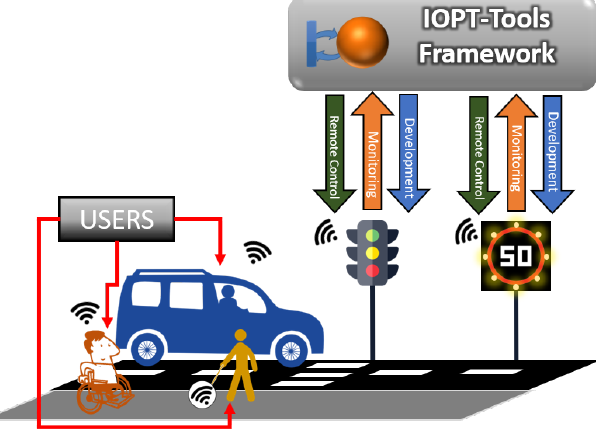
Figure 1. Mobility Assistive System (NOVA-MAS)